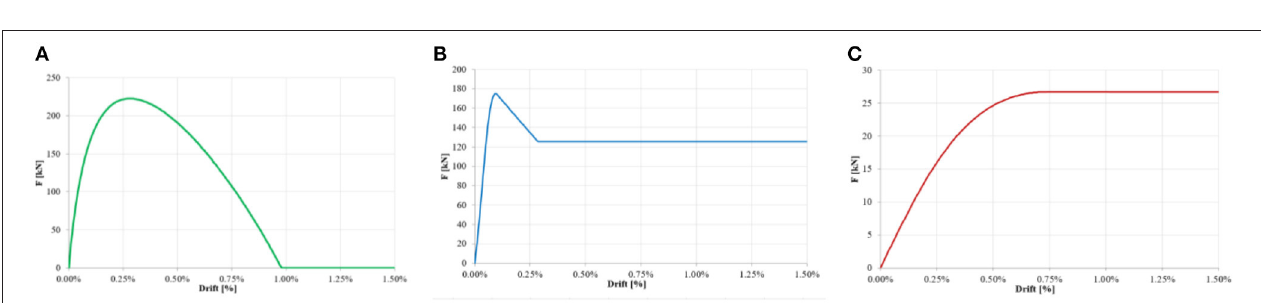
FIGURE 22 | Backbone curves for the infill contribution: (A) Traditional masonry infill “T2”; (B) Infill with sliding joints (TSJ); (C) semi-interlocking masonry (SIM).